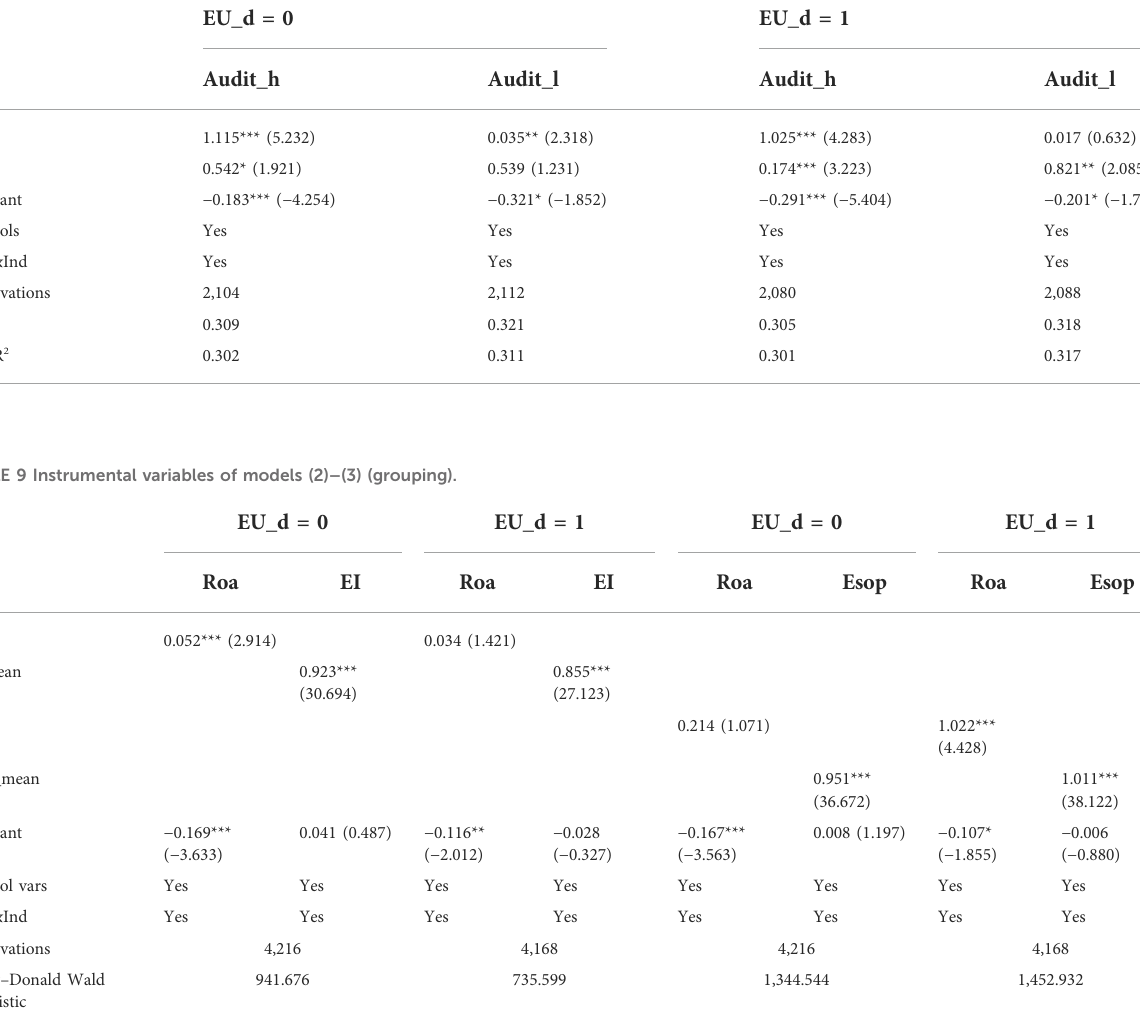
TABLE 8 Model (4) grouping test of external audit quality.